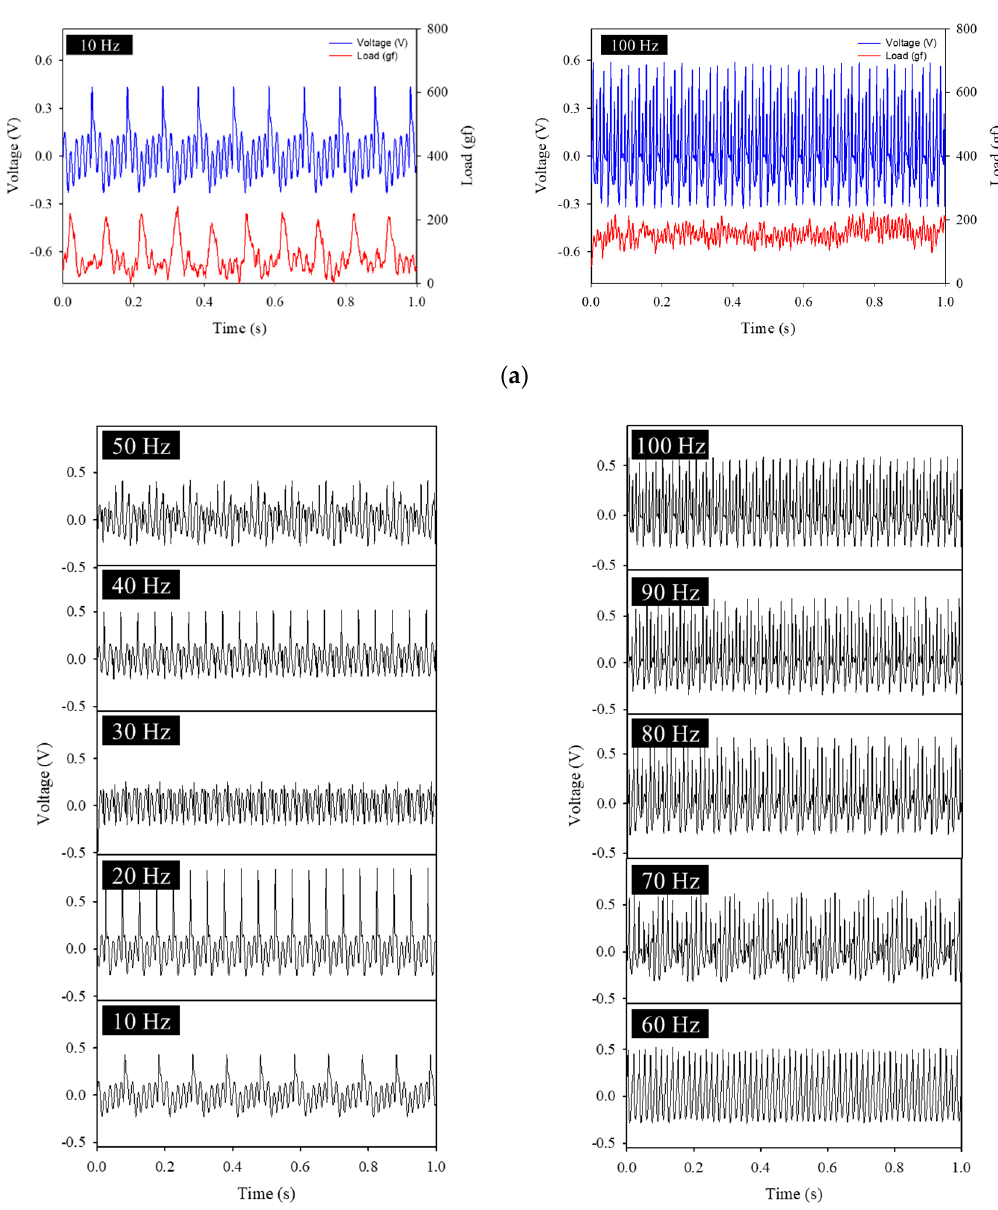
Figure 6. ( a ) Output voltages and applied loads for 10 and 100 Hz. ( b ) Output voltages of mechanical forces applied to the flexible piezoelectric device according to the frequency at 200 gf.